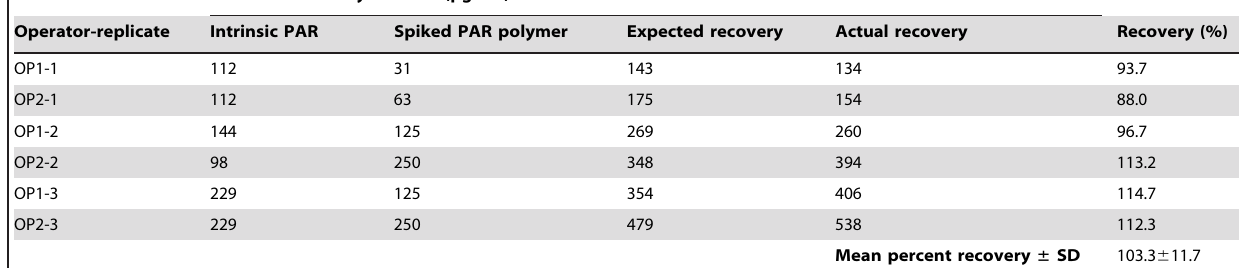
Table 1. Recovery of PAR from spiked PBMC extracts.